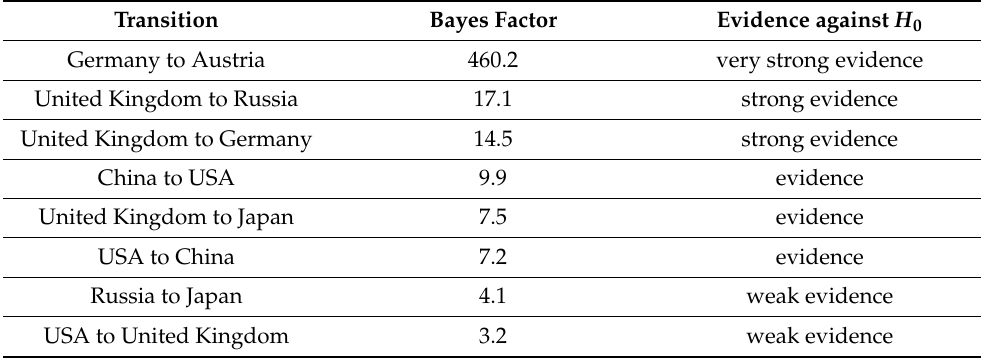
Table 4. Bayesian phylogeographic